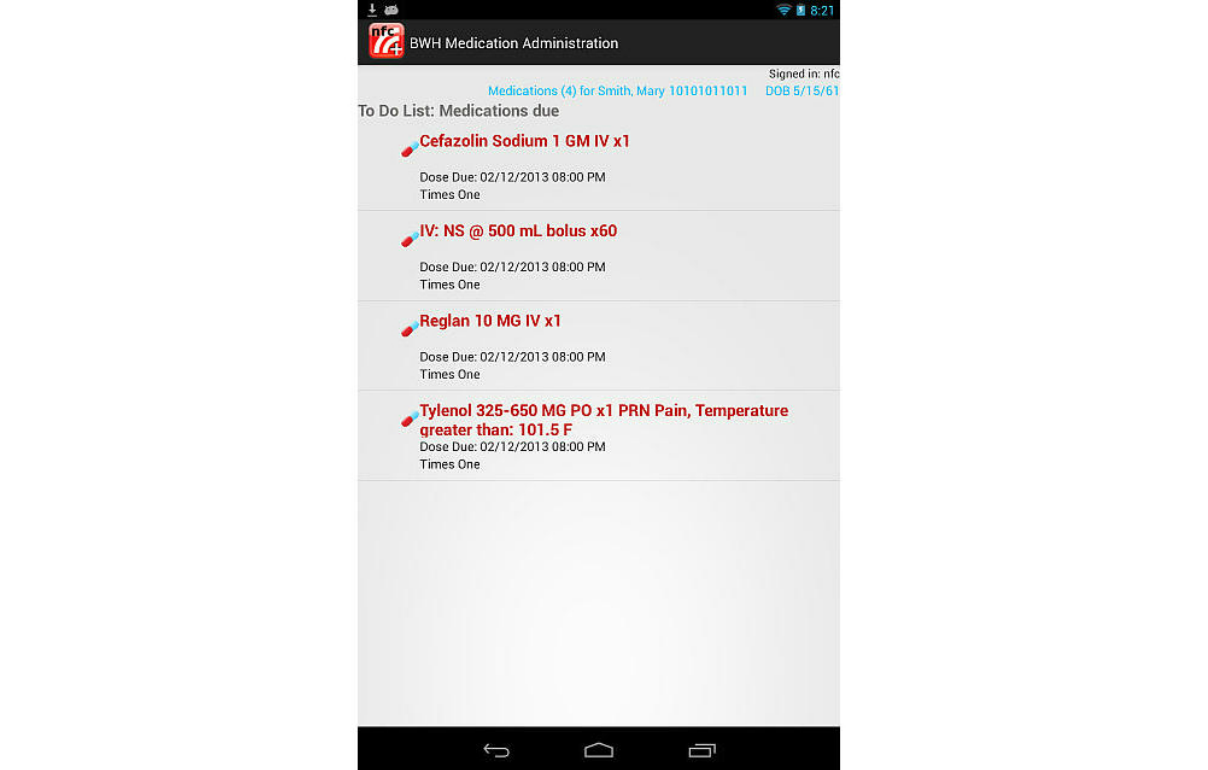
Figure 1. Prototype near field communication-enabled medication administration (NFCMA) system screenshot:medications due